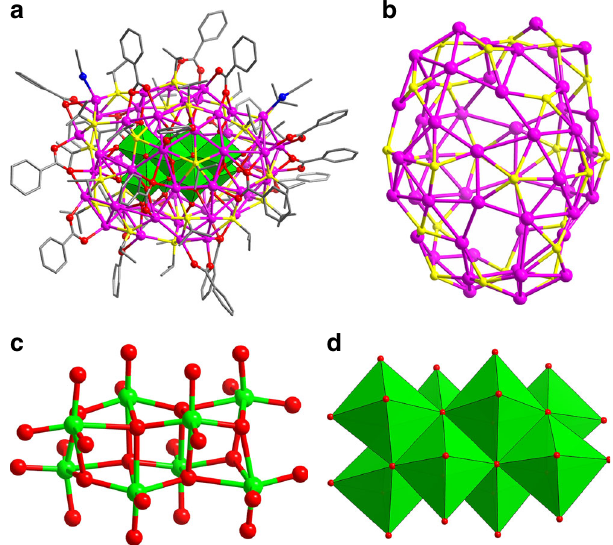
Fig. 3 Single-crystal X-ray structure of SD/Ag50 . a Molecular structure of SD/Ag50 trapping a Mo 8 O 28 8 − anion as template (Color legend: Ag: purple; S: yellow; Mo: green; O: red; C: gray; N: blue). b The ball-and-stick mode of Ag 50 S 24 shell. The ball-and-stick ( c ) and polyhedral ( d ) modes showing the inner Mo 8 O 28 8 −